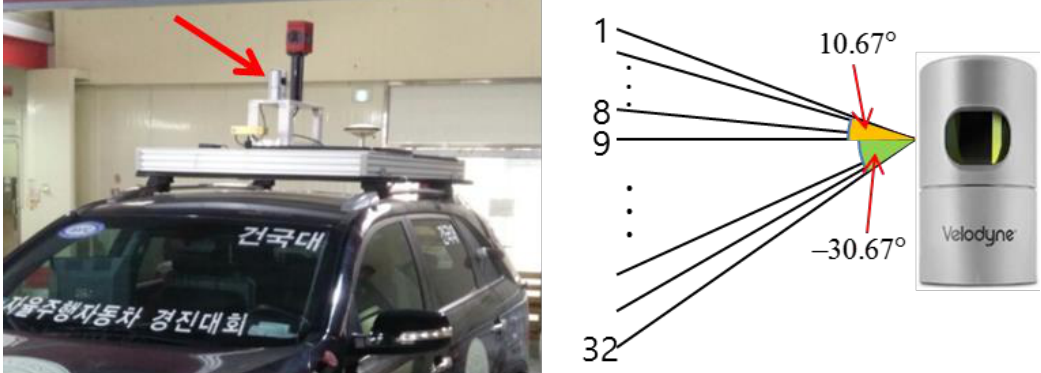
Figure 3. ( Left ) Installation position of Velodyne HDL-32E and ( Right ) vertical layer specifications.